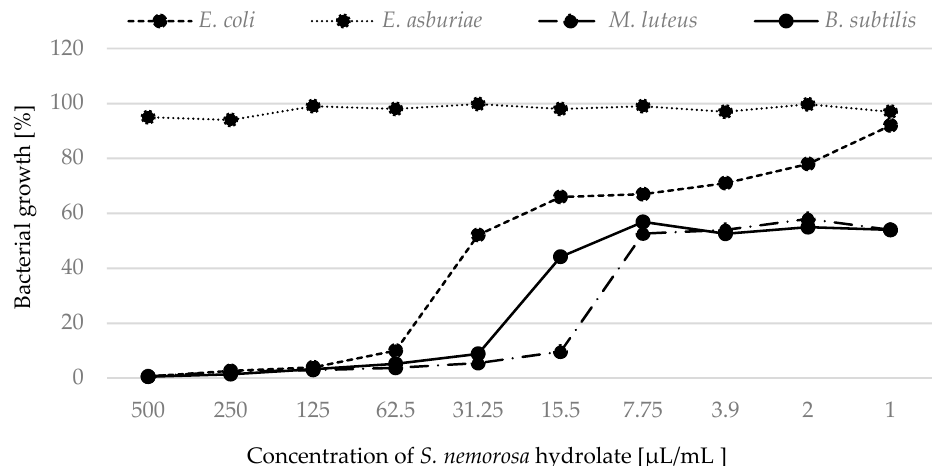
Figure 4. The growth of bacterial strains in the presence of S. nemorosa hydrolate. The least inhibitory effect was observed for the strain E. asburiae when treated with S. nemorosa hydrolate. The growth of M. luteus was completely inhibited by S. officinalis and by S. nemorosa hydrolates at a concentration of 125 μ L/mL.